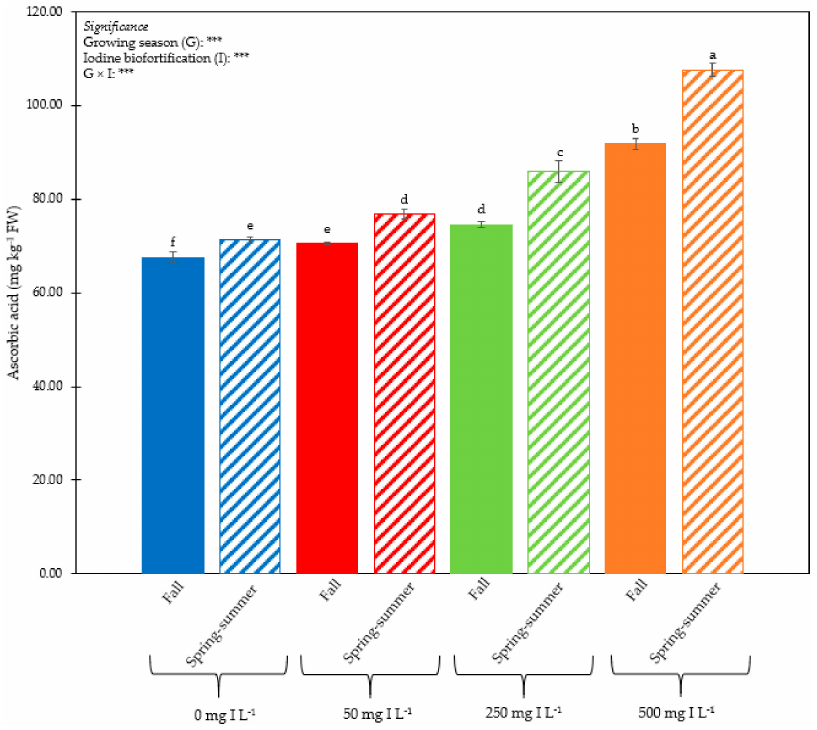
Figure 4. Ascorbic acid concentration as affected by combining growing season (fall or spring– summer) and iodine supply (0, 50, 250 or 500 mg L − 1 ) in curly endive. Different letters indicate significant differences at p ≤ 0.05. *** significant at